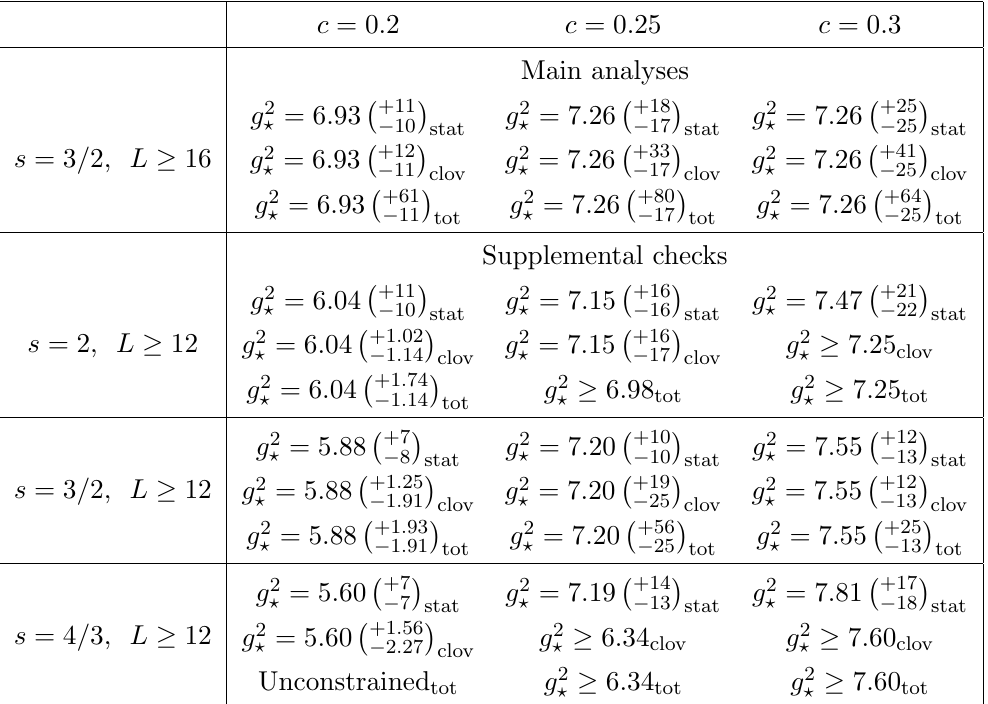
Table 2 . Results for g 2 from various combinations of scale change s , gradient (cid:13)ow renormalization ? scheme parameter c , and (in the case of s = 3 = 2) restriction on the lattice volume. The central values and statistical uncertainties in the top row of each entry come from the clover discretization of E ( t ). The middle row of each entry continues to consider the clover discretization, also accounting for the three sources of systematic uncertainties summarized in section 4. The third row presents the total uncertainties that include all systematics for both the clover and plaquette